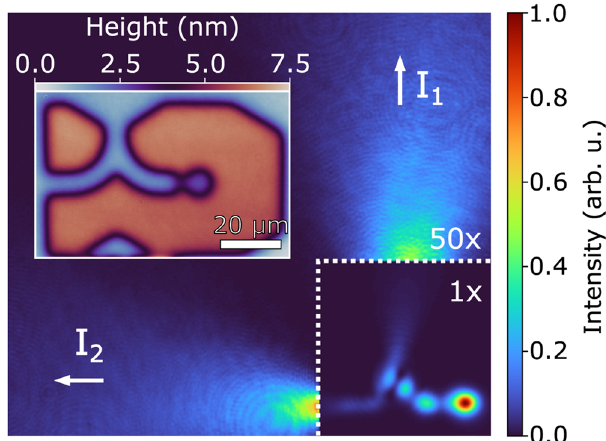
Fig. 2 Flow of light in the Y-coupler. A modi fi ed Y-coupler structure, as shown in the top left inset fi gure, is used to determine the splitting between photons fl owing out of the structure at the exits (I 1 , I 2 ). I 1 contributes to the dissipative component of the coupling, while I 2 contributes a dispersive component. The measured photon density in the area marked with '50x' is multiplied by that factor in order to improve visibility of this low intensity region and highlight the spatial extent of the wavefunction. The measured intensity is averaged over 100